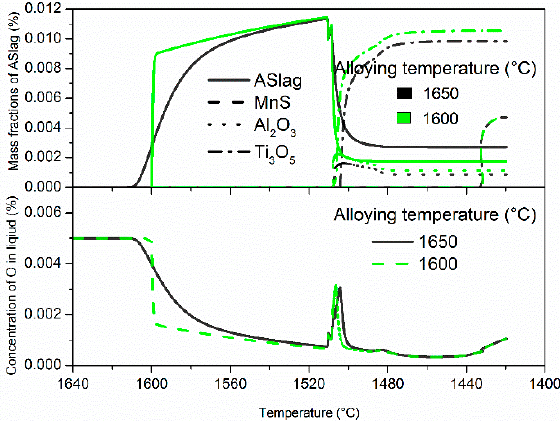
Figure 3. The mass fraction changes of the inclusions during the cooling and solidification process ( top ) and the corresponding changes of oxygen concentration ( bottom ) at the alloying temperatures of 1650 and 1600 °C.